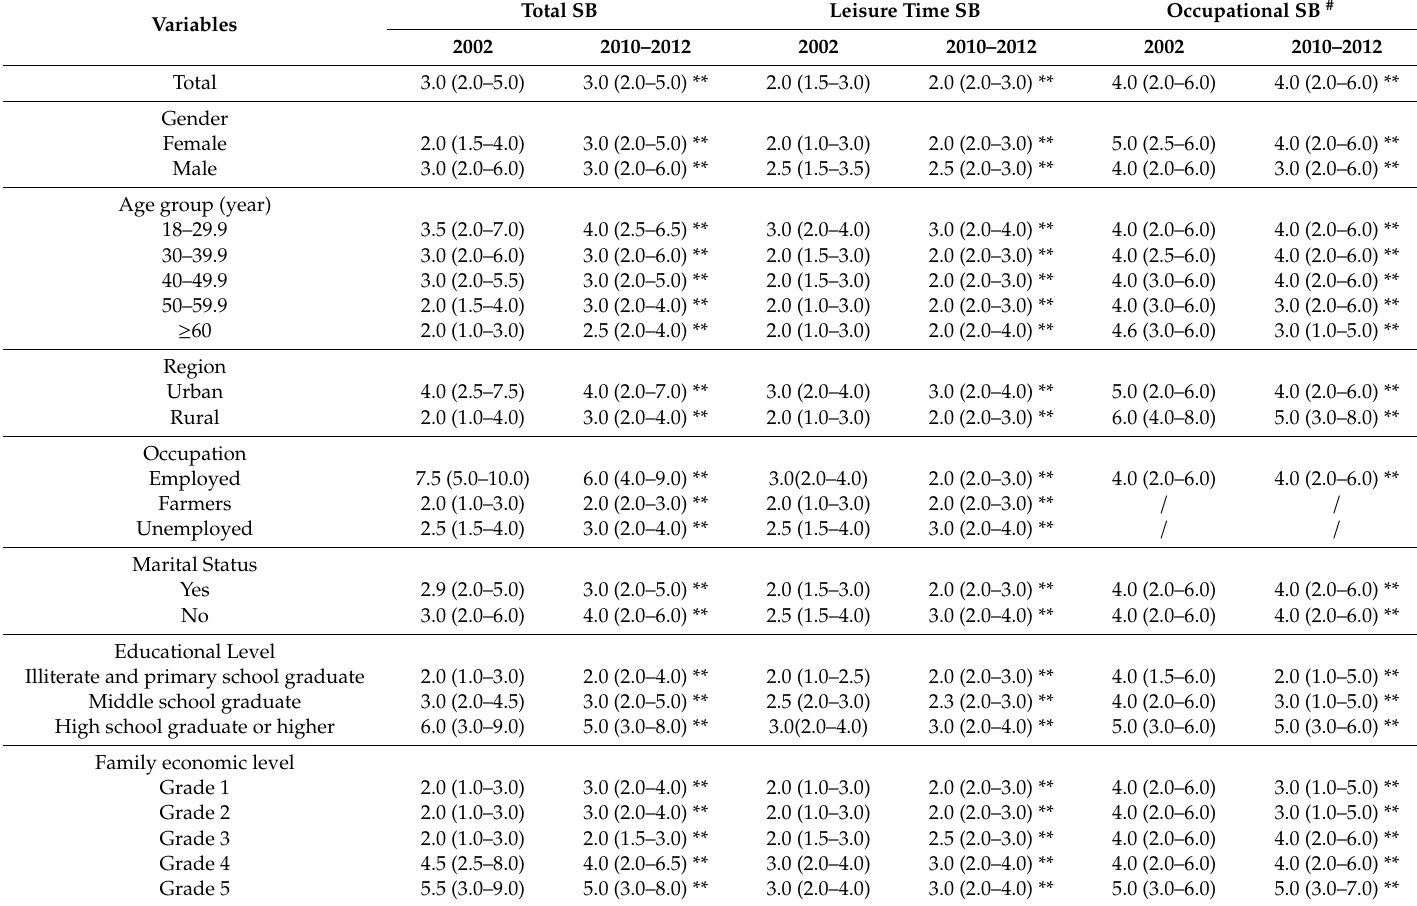
Table 2. Changes § of medians (P25–P75) in time of sedentary behaviors (SB) from 2002 to 2010–2012 (hours per